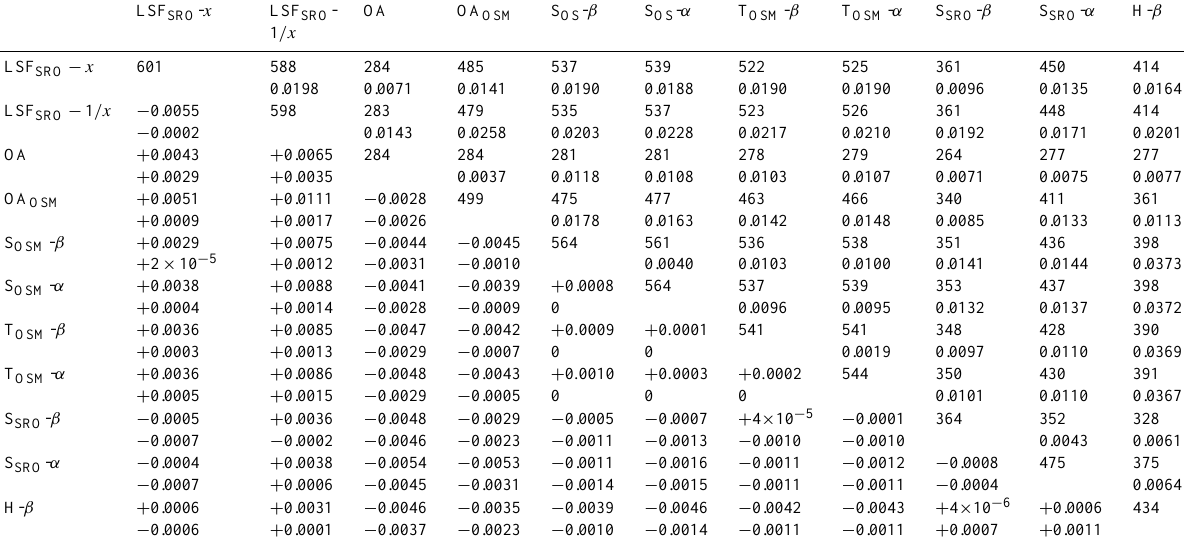
Table 1. The comparison among 11 Langley methods for rms ≤ 0 . 006. Number of successful Langley plots is on diagonal. Above the diagonal the number of common Langley plots for two methods and a standard deviation of differences (cid:49)α . Below the diagonal the mean and median of (cid:49)α . The order of subtraction in (cid:49)α is as follows: α for the method from row minus α for the method from the